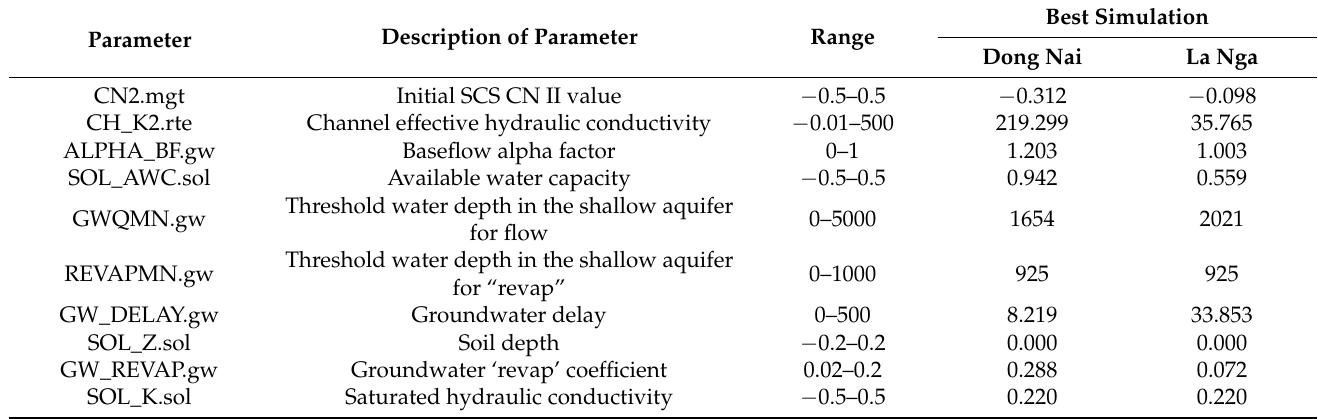
Table 2. Highly Sensitive Final Calibrated